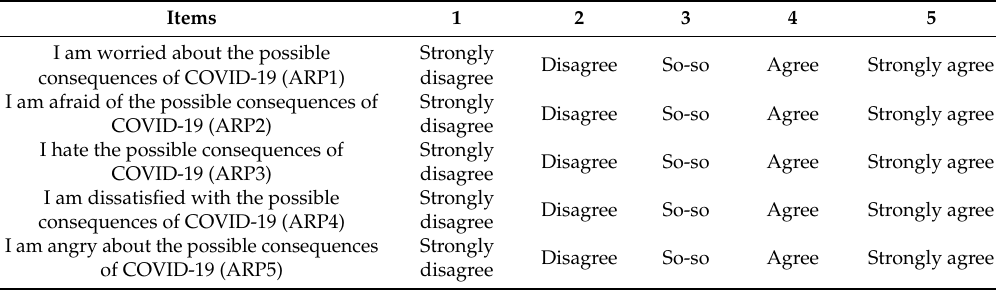
Table A3. Scale to measure a ff ective risk perception.